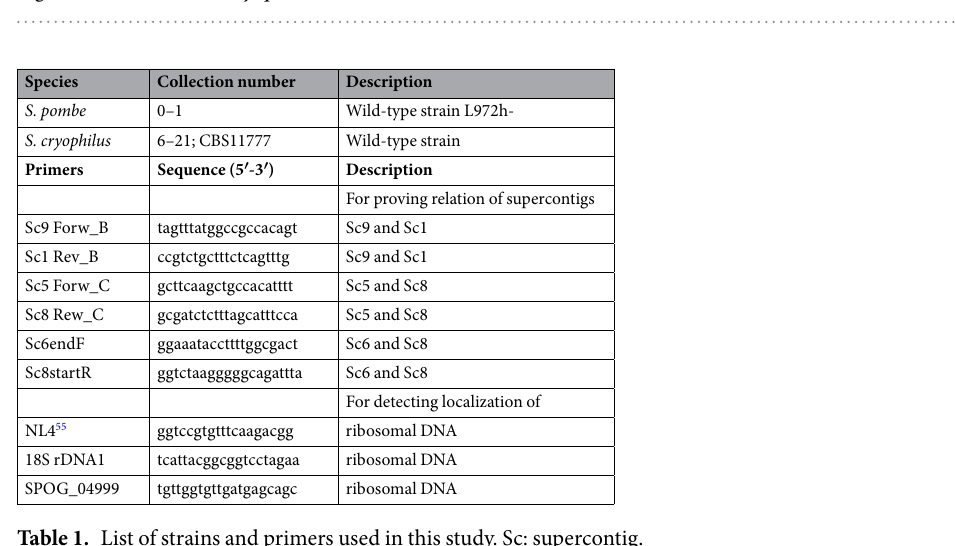
Figure 1. Pairwise whole genome alignments of the species created by Mauve 49 aligner, where the newly established supercontig (Sc) order of S. cryophilus was used. The large overlapping locally collinear blocks (LCBs) between the adjacent Scs provide support for the current Sc order. The alignments also indicate that S. cryophilus closest relative is S. octosporus . Colourful rectangles represent LCBs. Sizes of the rectangles are proportional to the genomic extensions of LCBs. LCBs below a genome’s centre line are in inverted orientation relative to the reference genome. Vertical black lines indicate the chromosome boundaries, vertical red lines show the inner supercontig boundaries of S. cryophilus . Wider red lines indicate positions of the centromeric regions in the case of S. cryophilus .